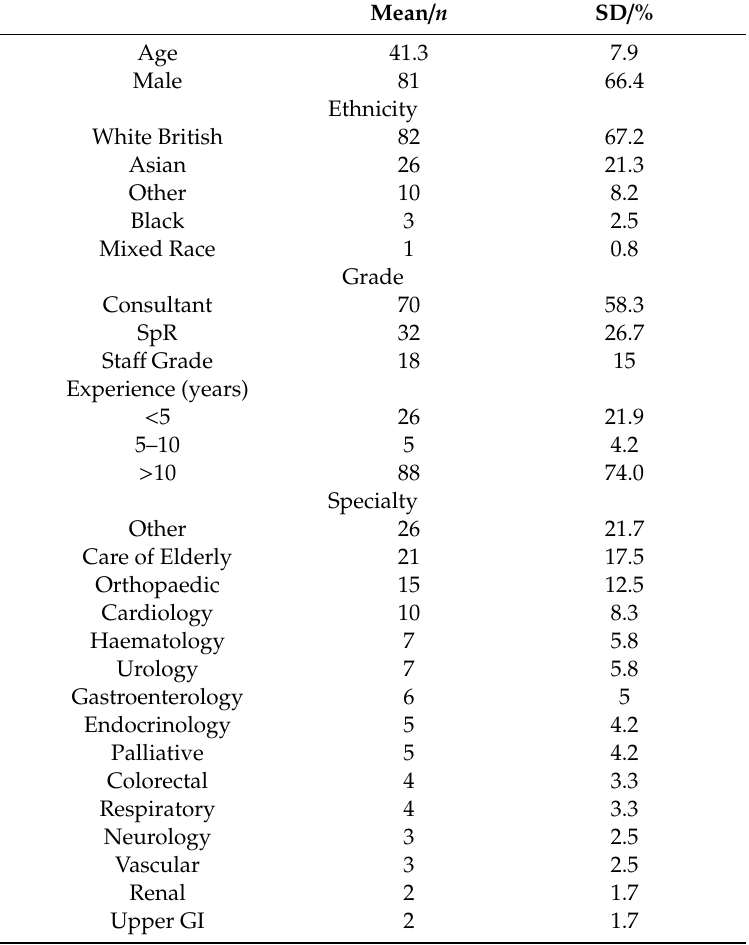
Table 1. Characteristics of respondents.